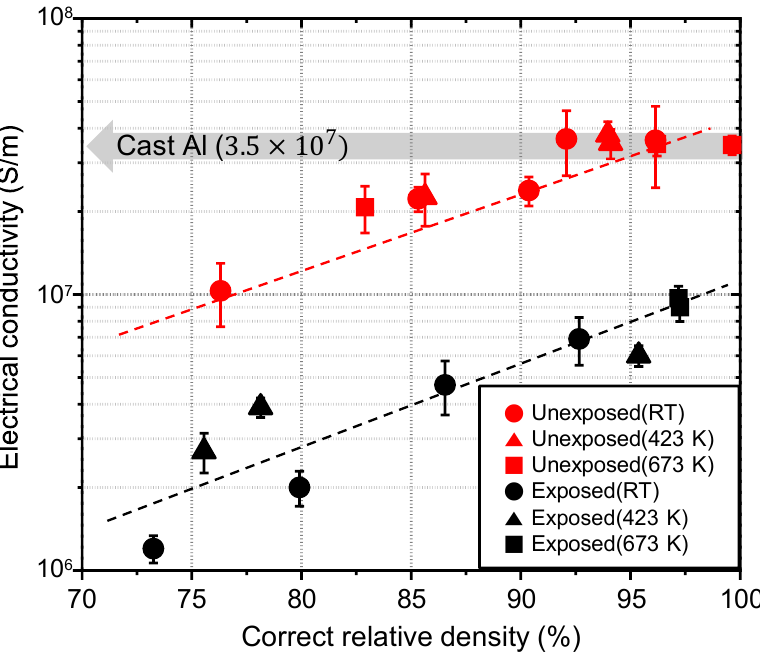
Figure 5. Electrical conductivity of cold-compacted or sintered unexposed and exposed Al compacts as a function of correct relative density.